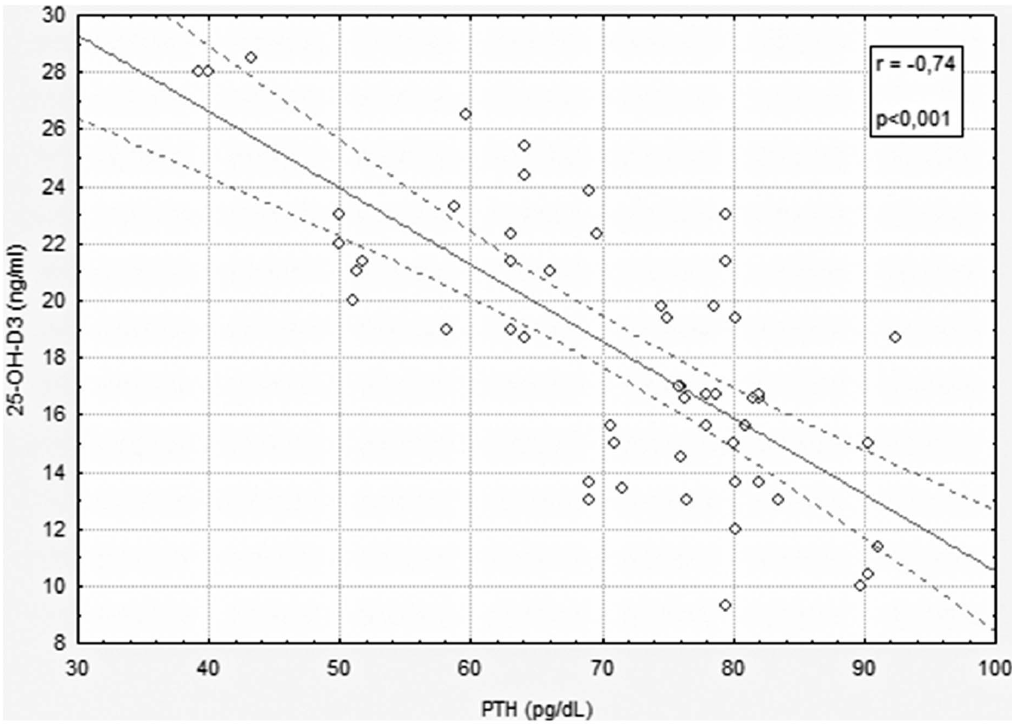
Figure 1. Negative correlation between parathyroid hormone level and 25-hydroxivitamin D level in SSc.